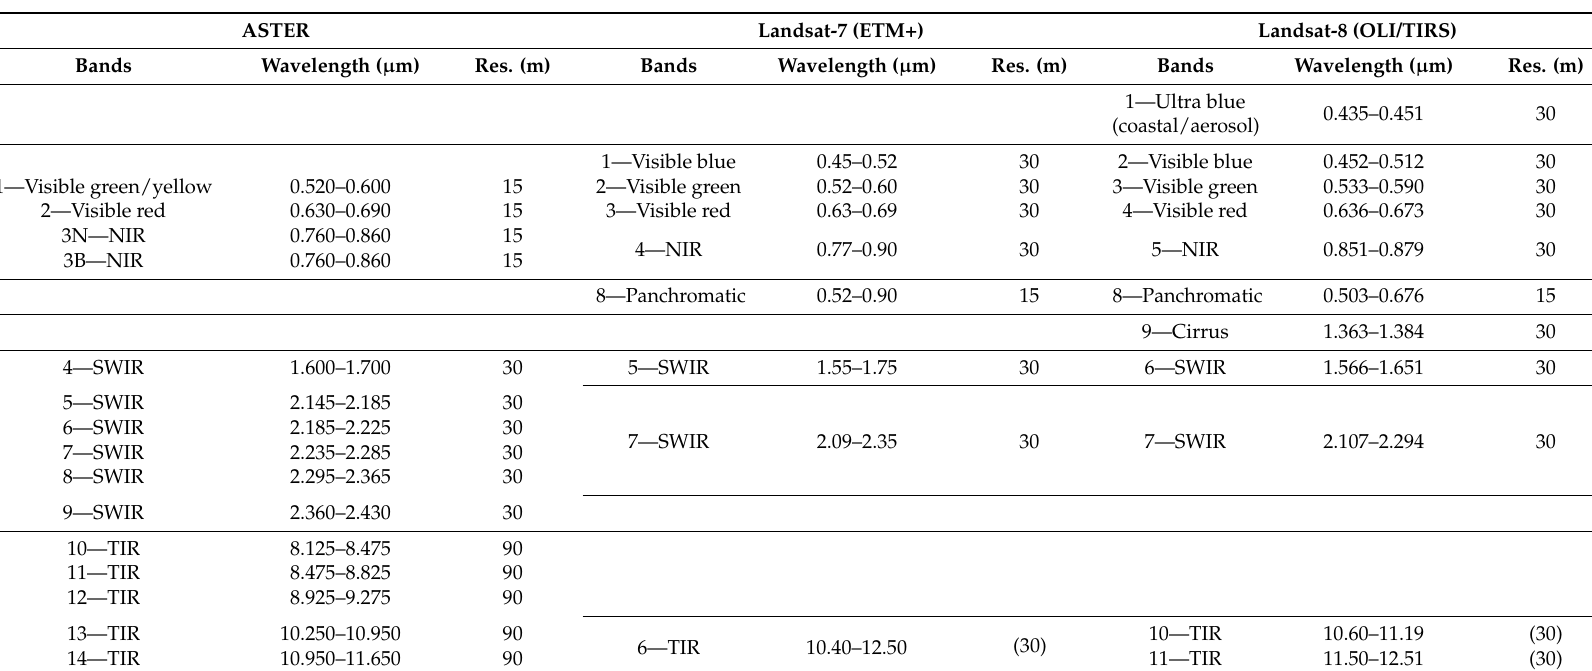
Table 1. Comparative table that highlights number of spectral bands and their characteristic features (i.e., wavelength and spatial resolution) in ASTER, Landsat-7 (ETM+) and Landsat-8